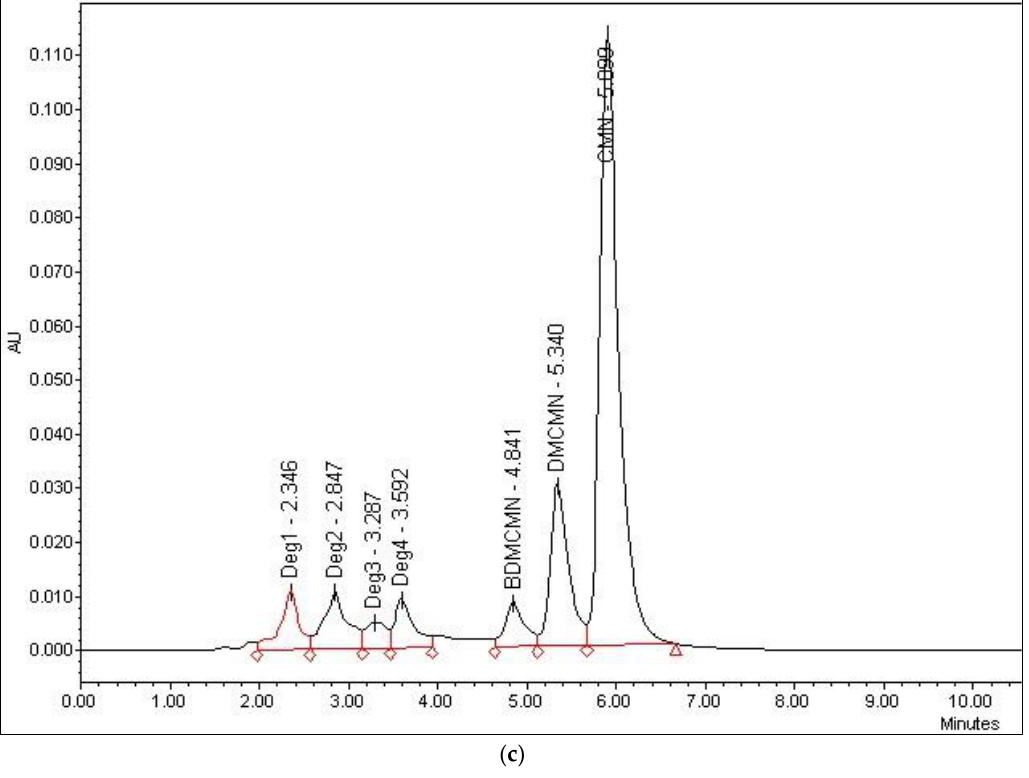
Figure 8. HPLC chromatograms of curcuminoids after exposure to ( a ) UV-irradiation; ( b ) degradation after exposure to sunlight; ( c ) degradation after exposure to oxidative conditions.